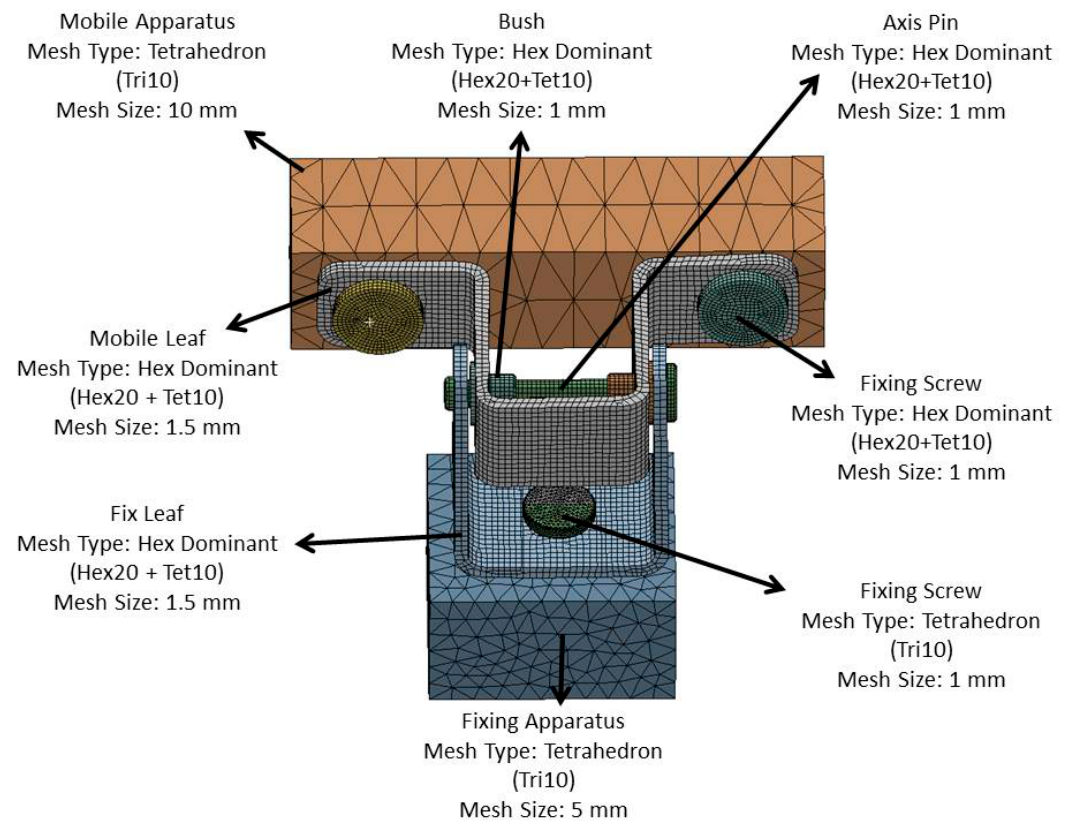
Figure 14. Finite element (FE) mesh properties of the door hinge system.